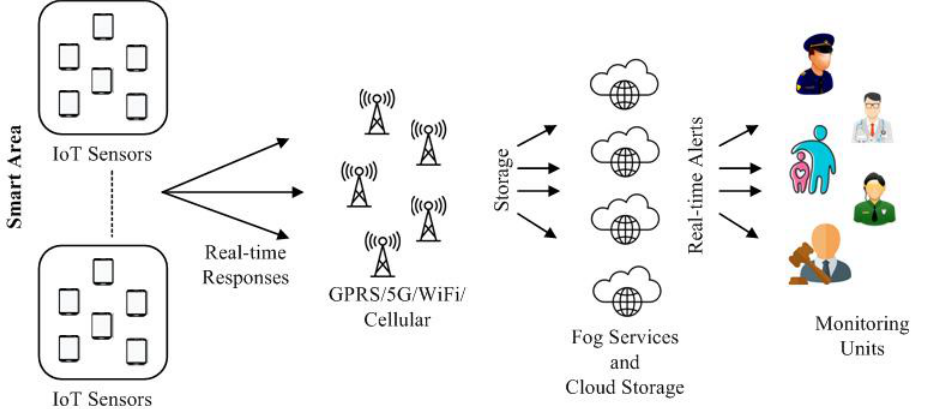
Figure 1. Low Power and Lossy IoT